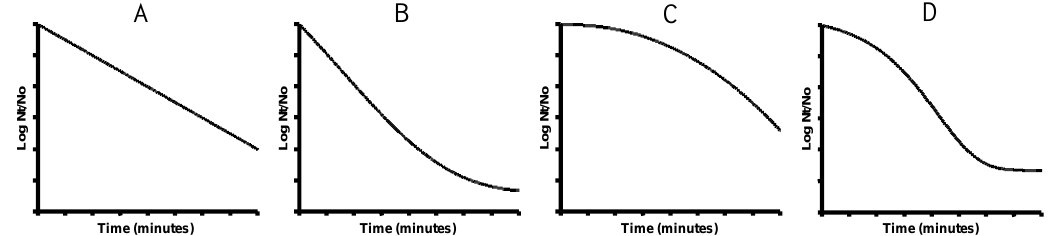
Figure 5. Profiles of heat survival curves. ( A ) Linear profile; ( B ) presence of tail, concave profile; ( C ) presence of shoulder, convex profile; ( D ) tail and shoulder, sigmoid profile.